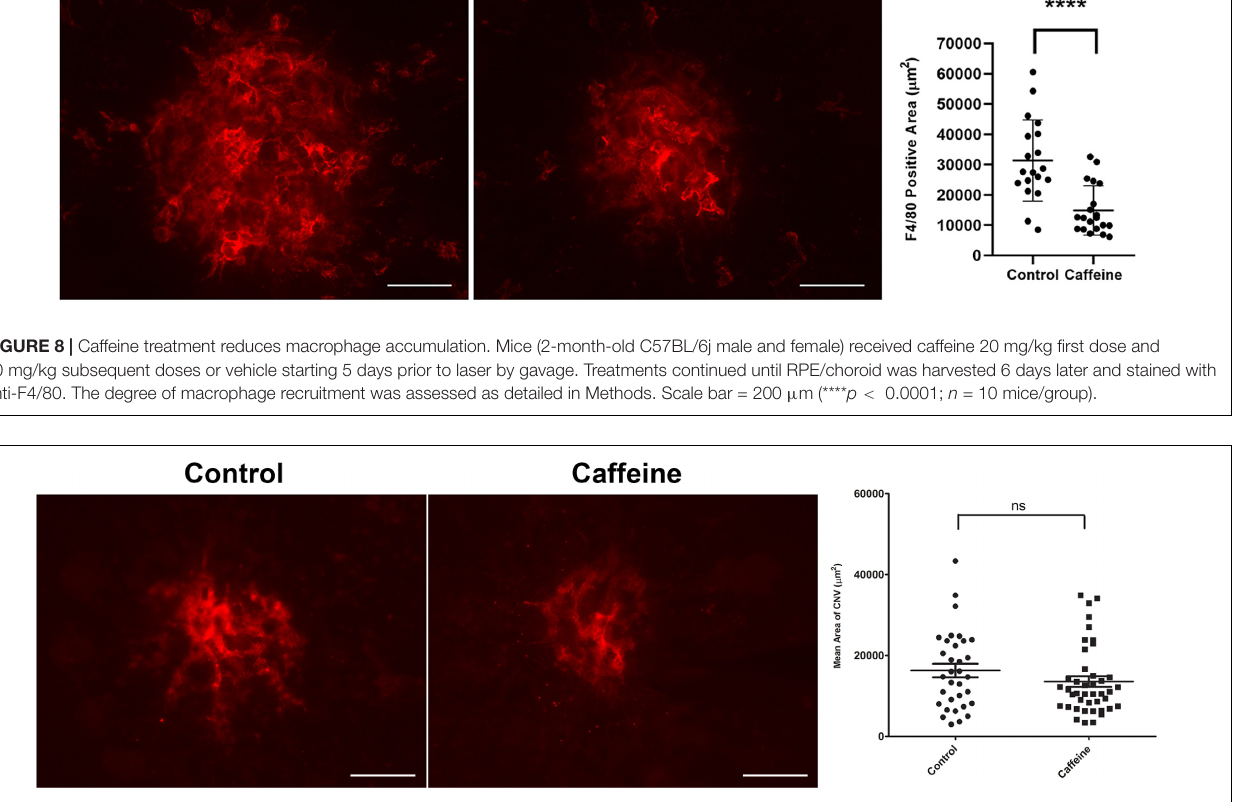
FIGURE 9 | Caffeine is not effective when administered to animals with established choroidal neovascularization (CNV). Mice (2-month-old; C57BL/6j male and female) received caffeine 20 mg/kg first dose and 10 mg/kg subsequent doses or vehicle starting 5 days following laser photocoagulation. Treatments continued until the choroid/RPE was harvested 2 weeks following laser photocoagulation and stained with anti-ICAM-2. Scale bar = 200 µ m (ns = not significant; n = 10